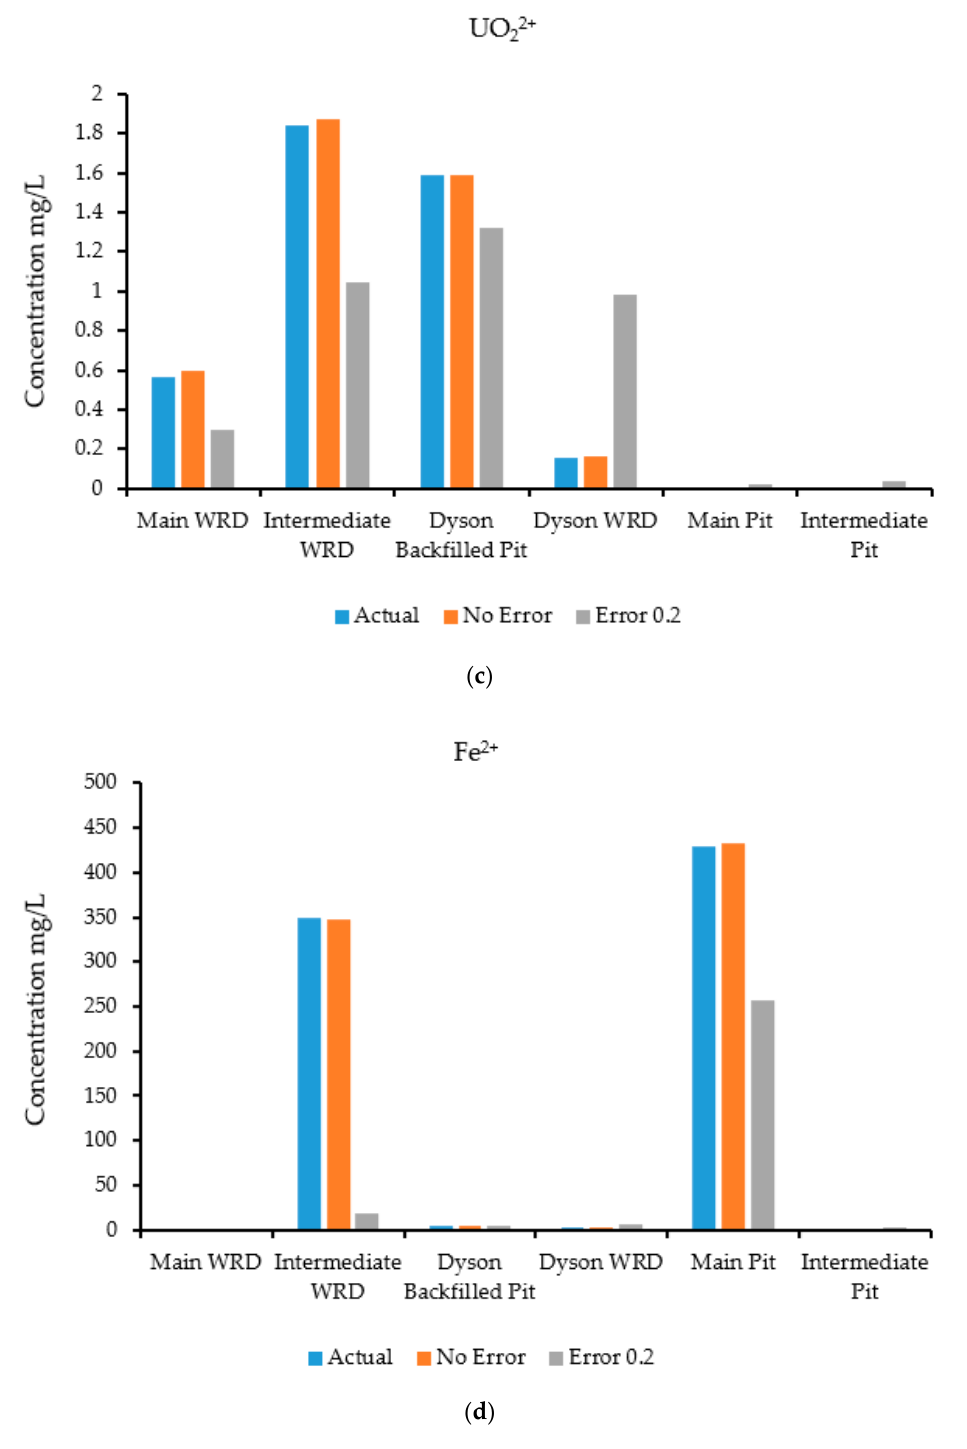
Figure 13. Comparison of species concentrations at sources with a perturbed error of 0.2: ( a ) Cu 2+ species; ( b ) SO 42- species; ( c ) UO 22+ ; ( d ) Fe 2+ species.